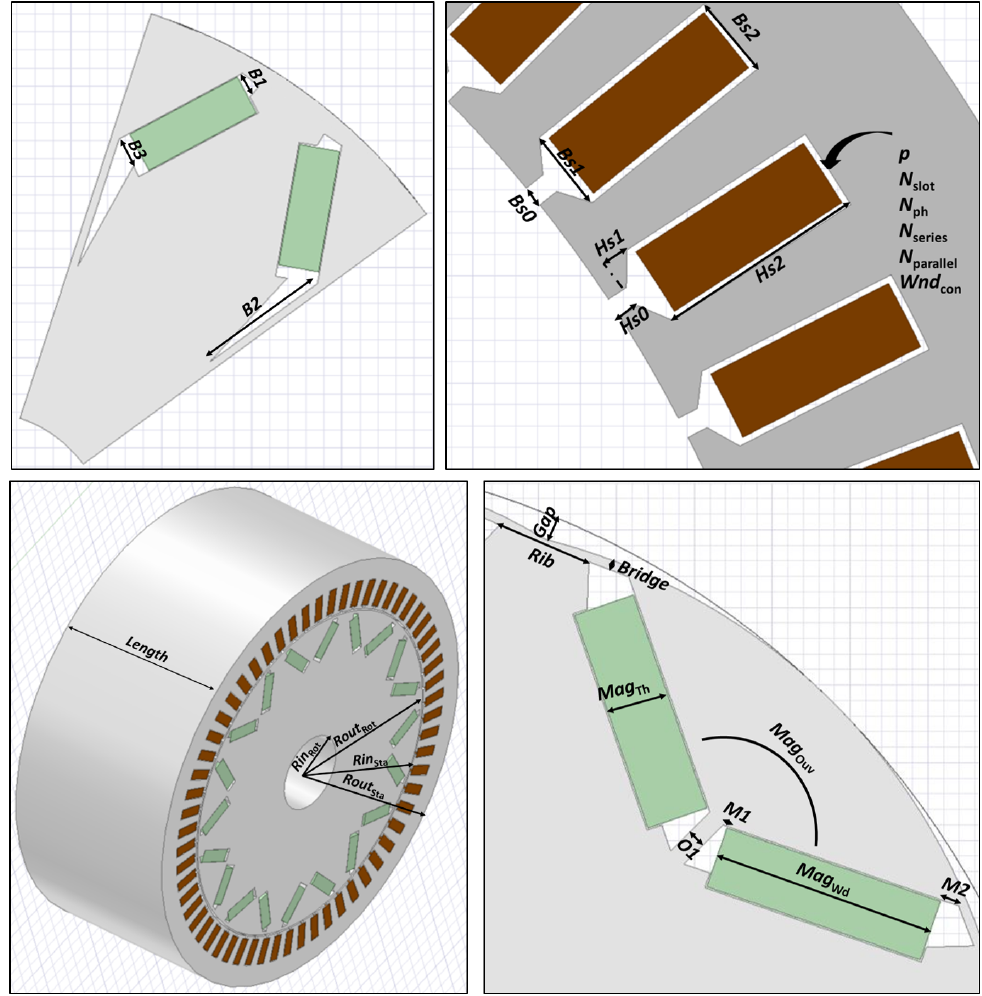
Figure 2. Machine design